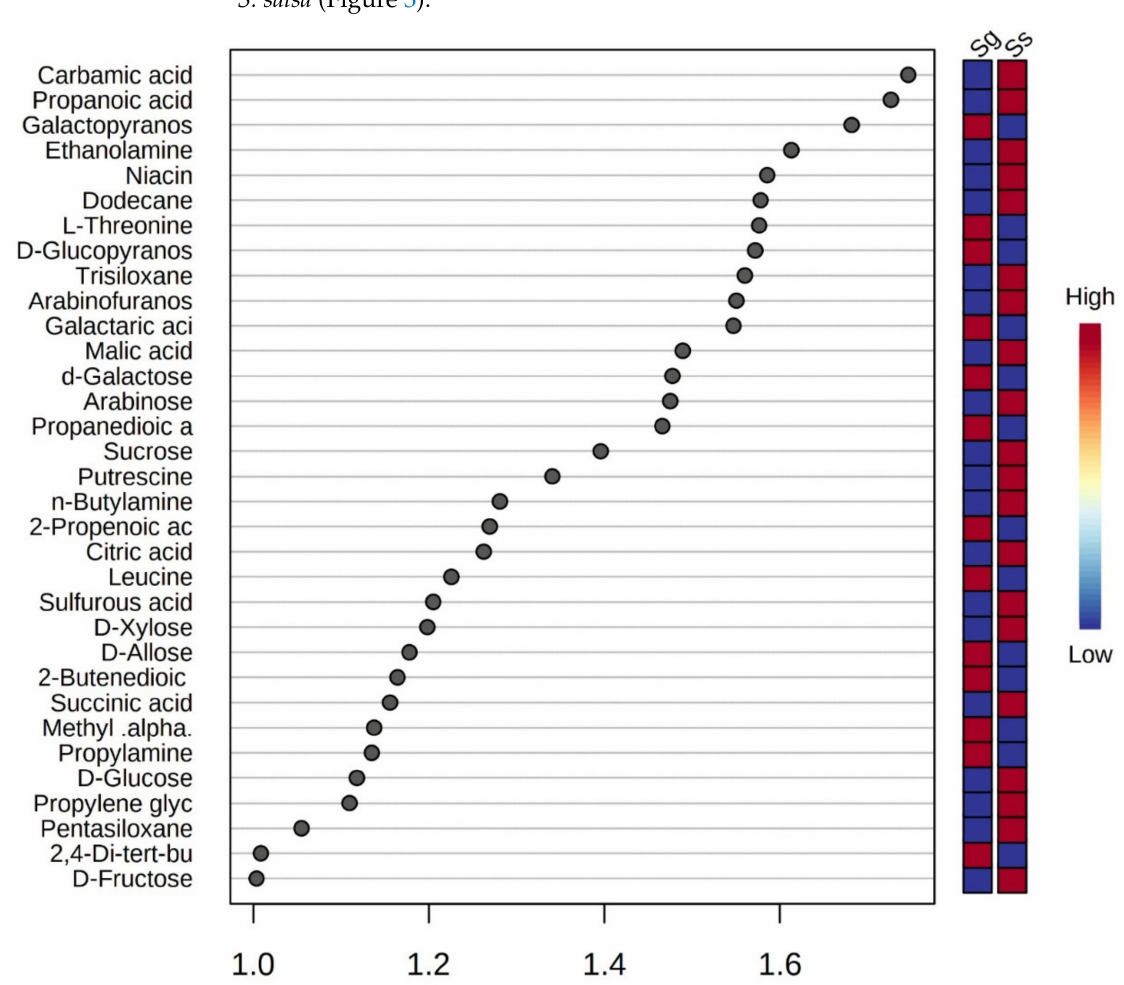
Figure 3. VIP score plots of discriminatory metabolites (VIP > 1) in the leaves of S. glauca and S. salsa . Red and blue-colored boxes on the right indicate up- and downregulation of metabolites in each plant. Sg: S. glauca ; Ss: S. salsa